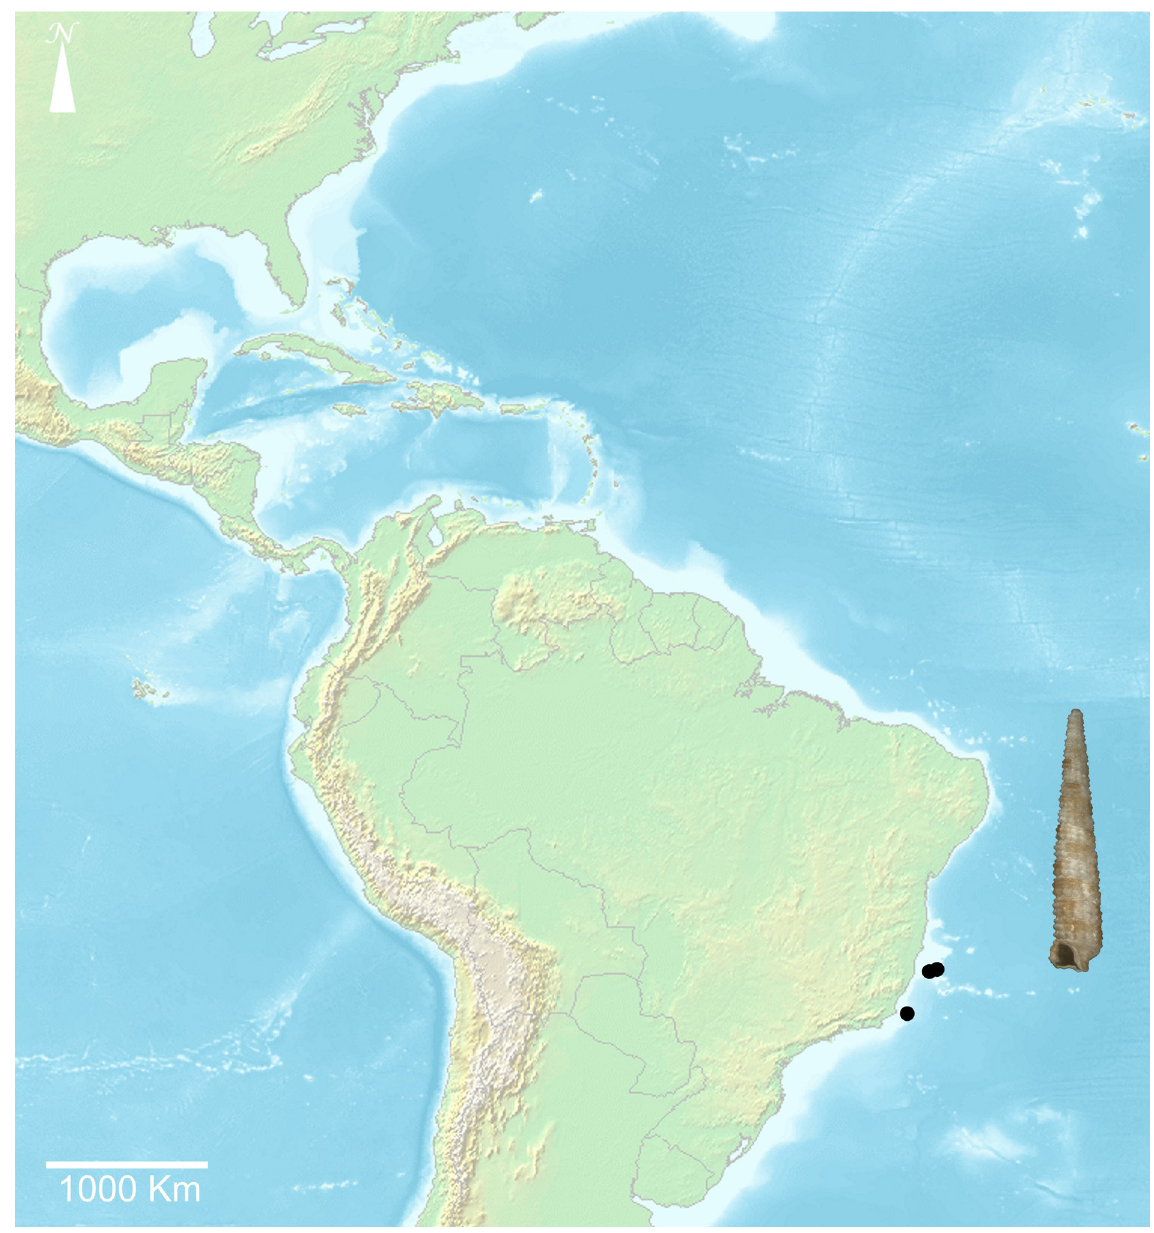
Fig. 44. Distribution map of Inella sp.